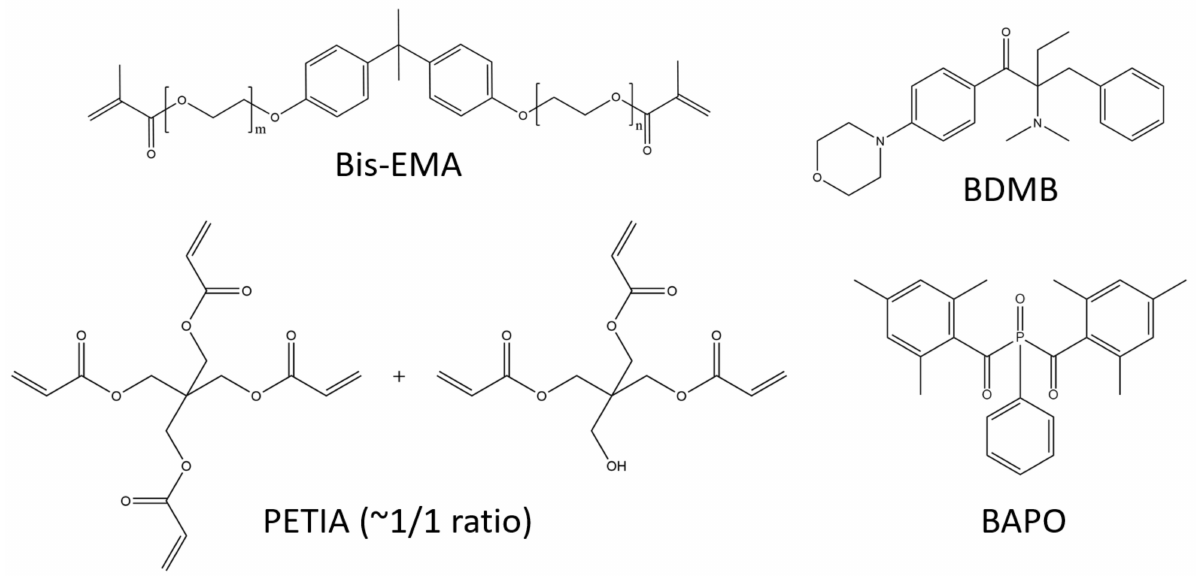
Figure 2. Primary oligomer Bis-EMA is di-functional while PETIA has tri- and tetra-functionality. BAPO is a common photobleaching PI, while BDMB is highly